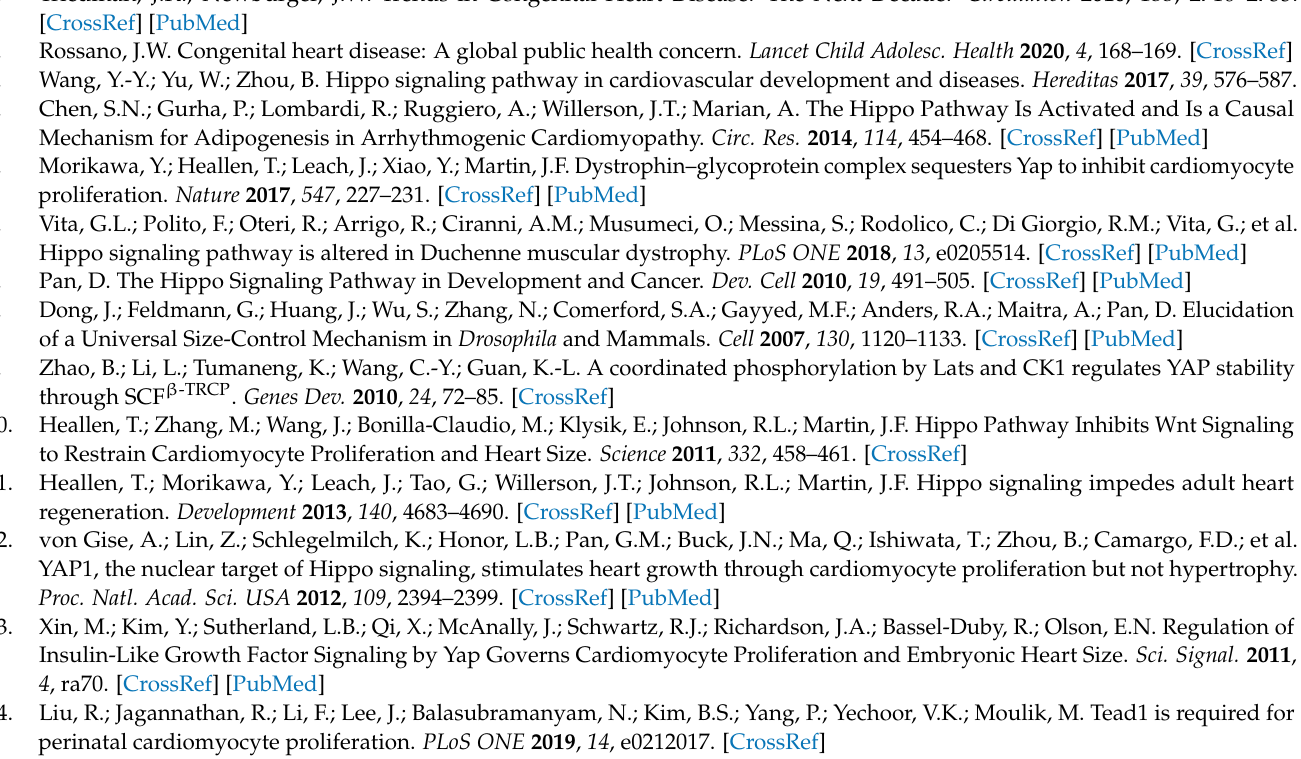
type mice; Figure S3: Histology of the embryonic and neonatal Vko hearts; Figure S4: